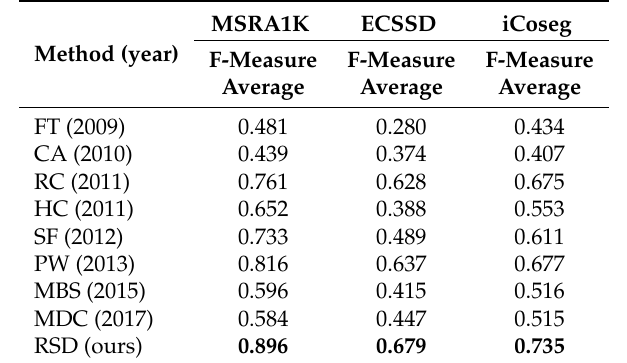
Table 4. The averaged F-measure of the results obtained on each fixed threshold. The model with the highest performance is highlighted in